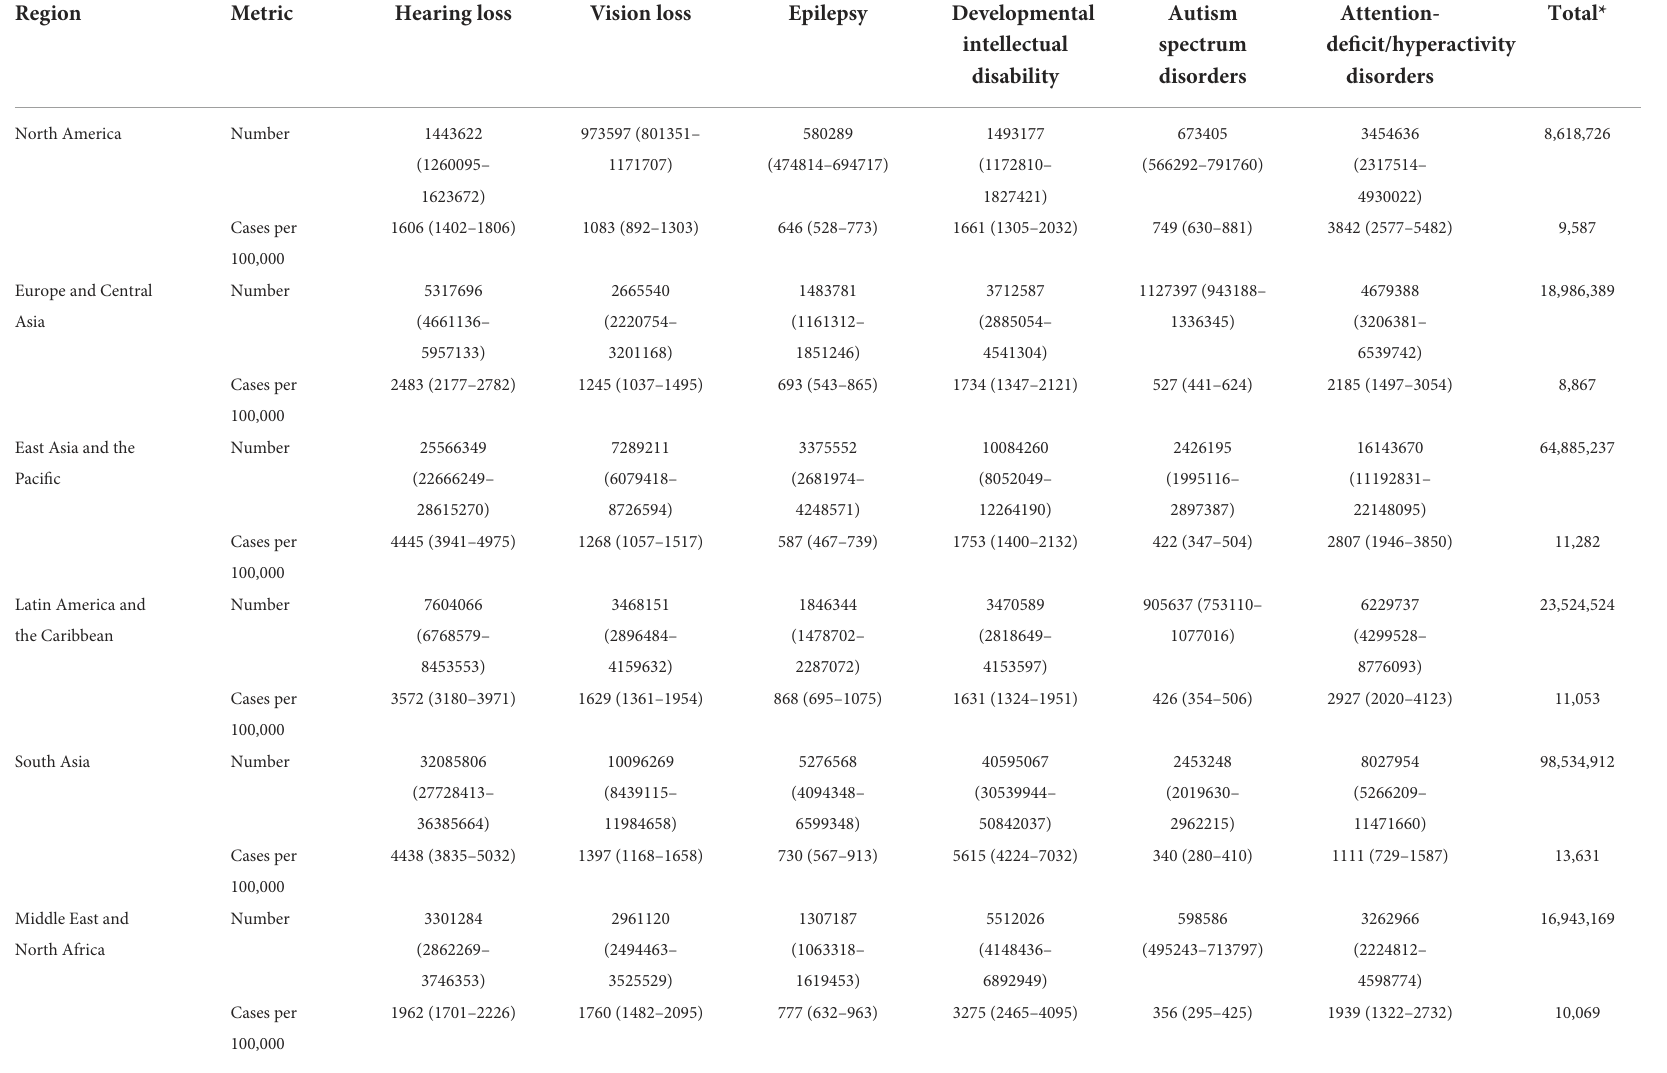
TABLE 5 Global and regional prevalence estimates (95% uncertainty intervals) of disabilities among children younger than 20 years from GBD